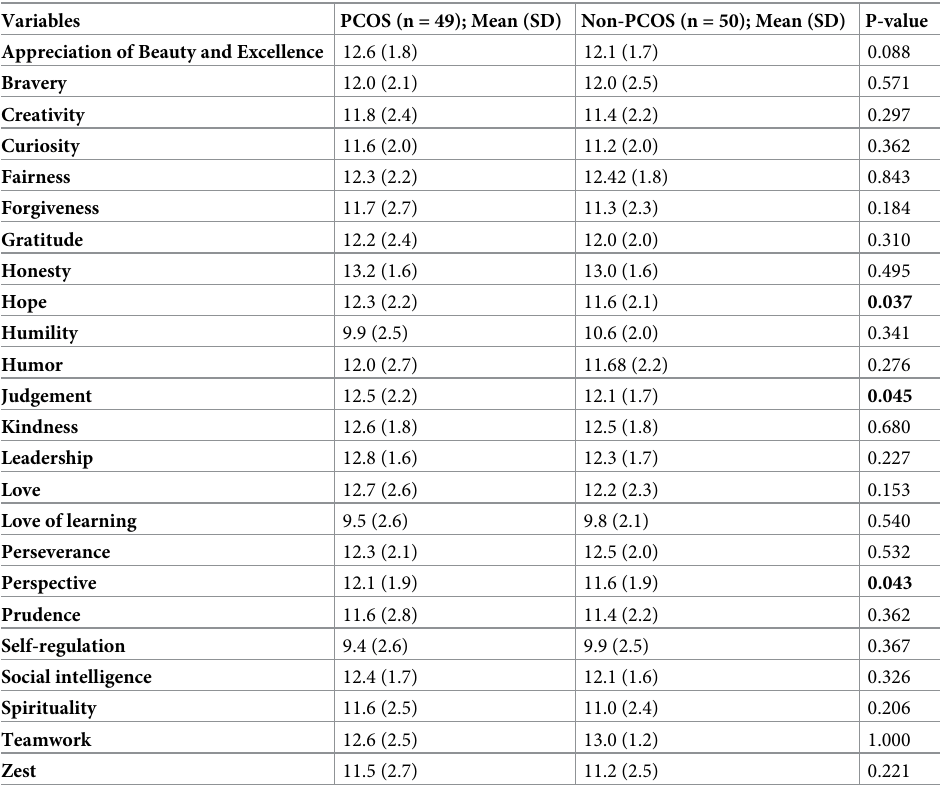
Table 3. Comparison of 24 character strengths between the two groups.